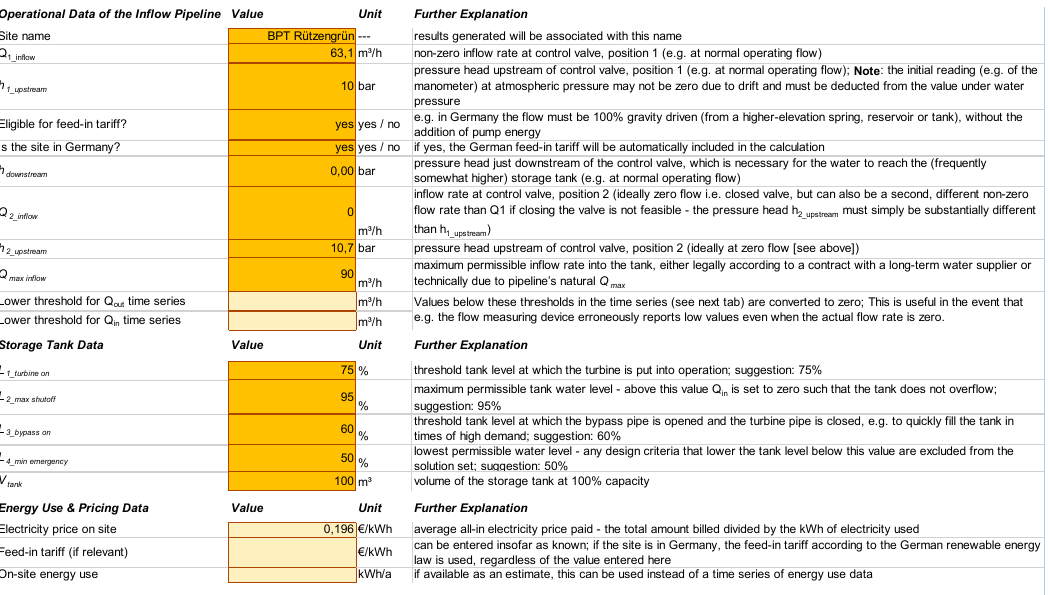
Figure 6. Excerpt of the first data input mask for single values, with values for BPT Rützengrün.